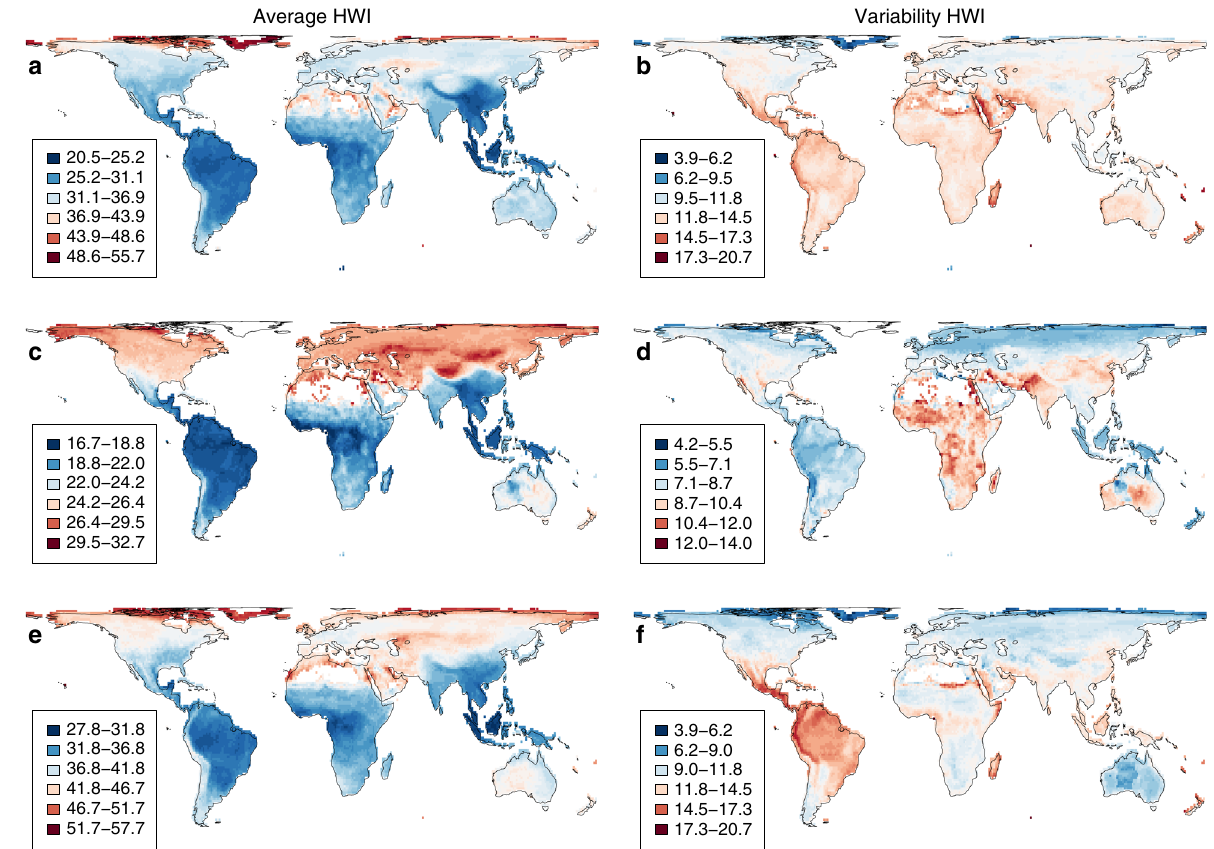
Fig. 3 Global variation in hand-wing index (HWI). Maps are shown for all birds ( a , b ; n = 8504), passerines ( c , d ; n = 5153), and non-passerines ( e , f ; n = 3351). HWI is calculated for grid-cell assemblages as both average ( a , c , e ) and variability ( b , d , f ). Each grid cell represents a 1°×1° square